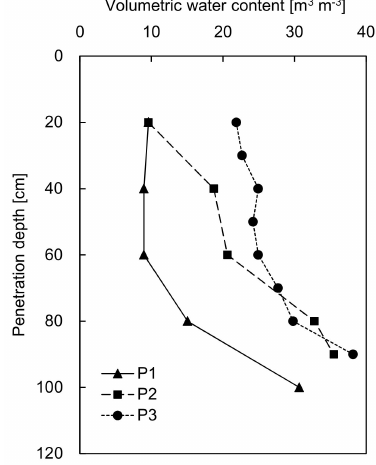
Figure 8. Volumetric water content profiles estimated from using PTDR.